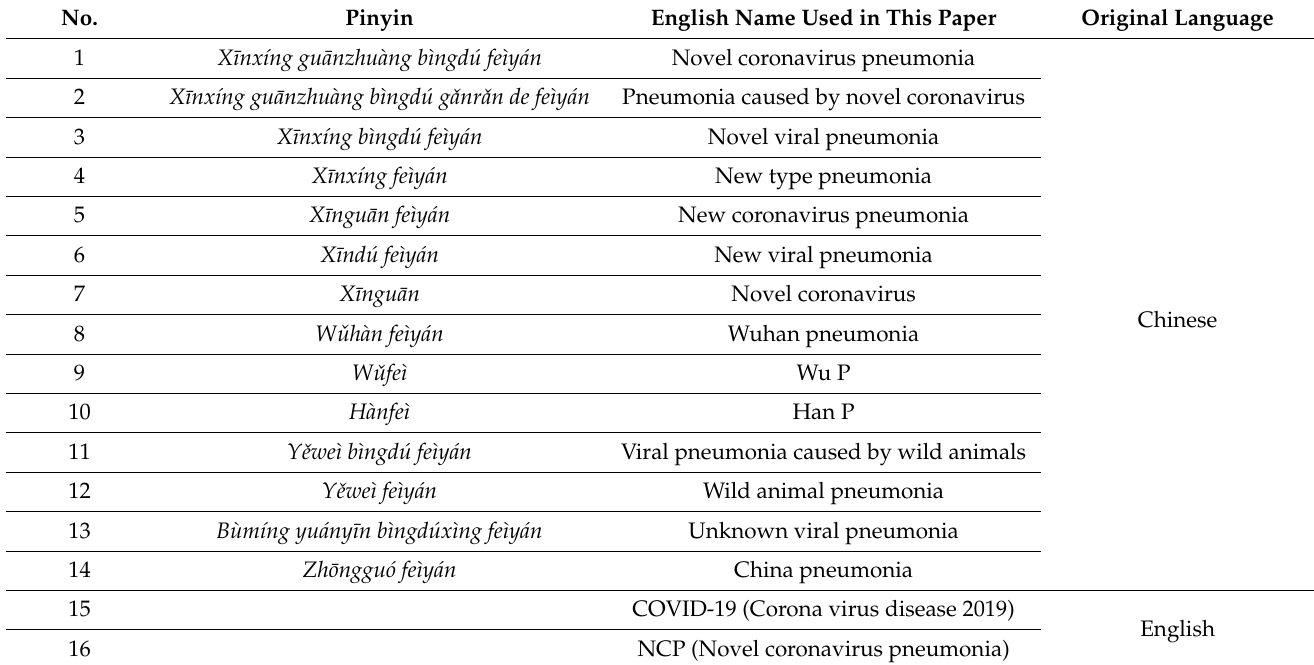
Table 1. List of 16 COVID-19 names selected; coronavirus disease name survey 2020.